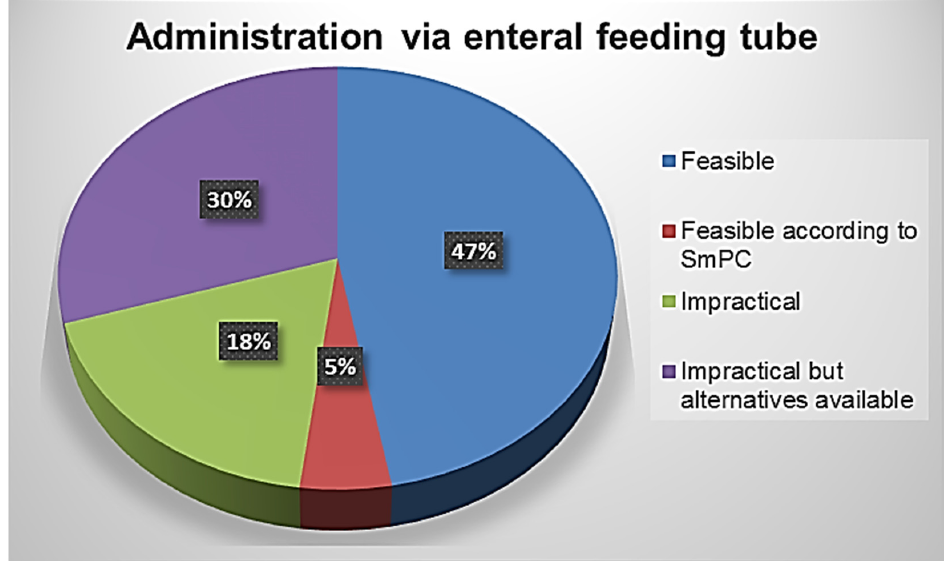
Figure 4. Feasibility of drug administration via enteral feeding tube of the solid oral dosage forms included in the Savona hospital formulary.